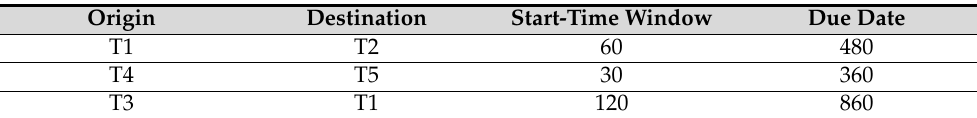
Table 1. Example of TO